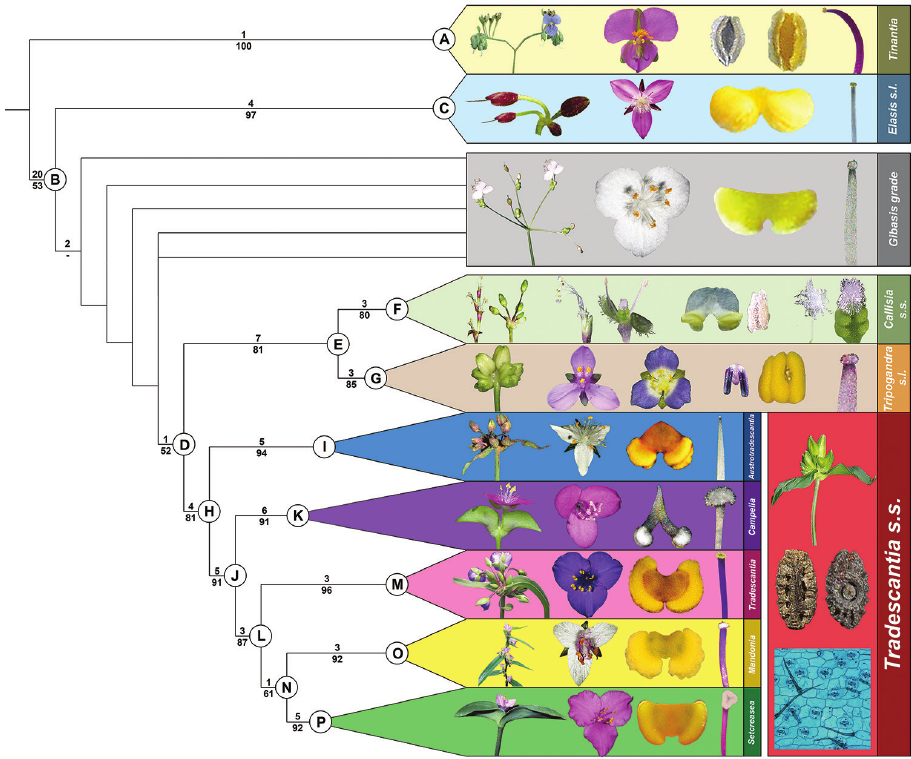
Figure 5. Majority-rule tree showing the relation between the genera in the Tradescantia alliance, high- lighting the reproductive synapomorphies recovered for each lineage. Synapomorphies for Tinantia (clade A ): cincinni verticillate, flowers zygomorphic, filaments sigmoid, anthers dimorphic with inconspicuous connectives, style sigmoid, stigma truncate, and hilum C-shaped. Synapomorphy for clade B : basal bract inconspicuous and tubular. Synapomorphies for Elasis s.l. (clade C ): cincinni fasciculate, flowers actino- morphic, filaments sigmoid, anthers dimorphic, style sigmoid, and stigma truncate. Synapomorphies for clade D : double-cincinni fused back to back. Synapomorphies for clade E : seeds triangular to round trian- gular or tetrahedral, ventrally ridged, hilum elliptic or punctate, and leaf epidermis with silica crystals in specialized cells with thickened cell walls. Synapomorphies for Callisia s.s. (clade F ): inflorescences mainly axillary, bracteoles conspicuous, pedicels apically non-gibbous, and penicilliform stigma. Synapomorphies for Tripogandra s.l. (clade G ): floral display with a 60° torsion, petals ranging from pink to lilac to purple, antesepalous filaments shorter than the antepetalous, and filaments sigmoid at anthesis and post-anthesis. Synapomorphies for Tradescantia s.s. (clade H ): double-cincinni fused back to back; frondose cincinni bracts, pedicels deflexed at post-anthesis, seeds elliptic to oblong in outline, ventrally flattened, hilum linear and longer than ½ the length of the seed, leaf epidermis lacking silica bodies in specialized cells, and diffuse bundle sheath in the mesophyll. Synapomorphies for T. subg. Austrotradescantia (clade I ): sepals elliptic to broadly elliptic, all keeled, filaments basally and densely bearded with long moniliform hairs, style obconic at base and conic at apex, and stigma punctate with type D papillae. Synapomorphies for clade J : overlap- ping cincinni bracts, conspicuous bracteoles sometimes completely involving the cincinnus, membranous sepals, stigmatic papillae equal or shorter than 1μm, and conspicuous embryotega. Synapomorphies for T. subg. Campelia (clade K ): synflorescence with one or more coflorescences, presence of peduncle bracts, presence of supernumerary bracts, spathaceous cincinni bracts, flowers with pedicels geniculate at